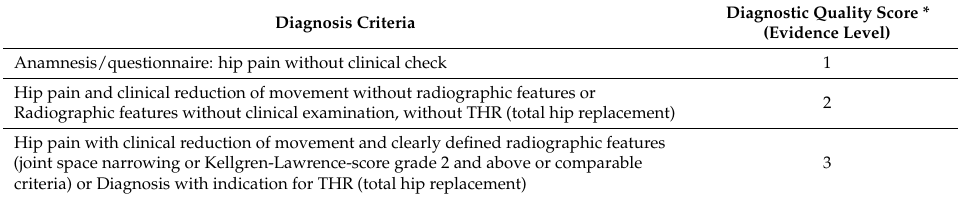
Table 1. Definition of level of evidence for diagnostic evaluation of studies on osteoarthritis of the hip (score 1–3) [2]. Diagnosis Criteria